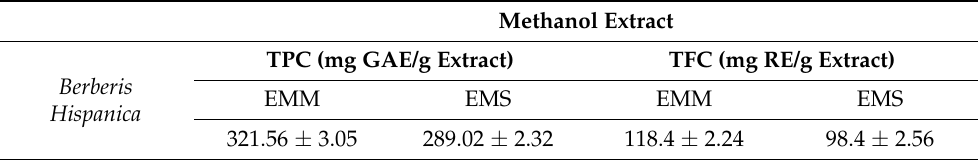
Figure 2. Quercetin calibration curve used for total quantification. Table 1. Total phenolic and flavonoid contents in B. hispanica extracts.